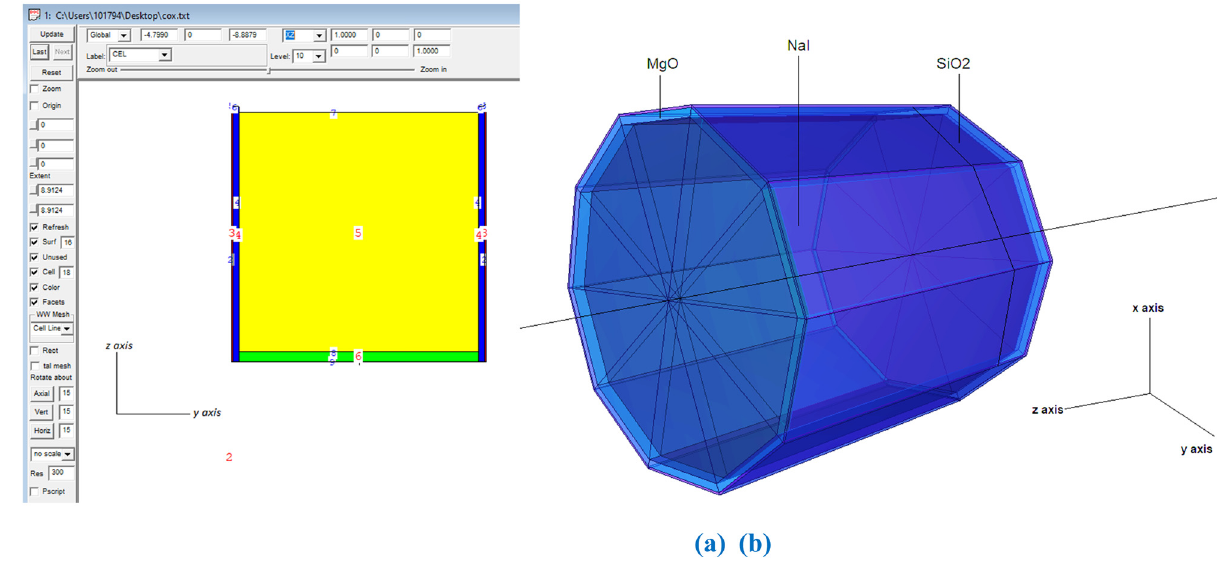
Figure 1: ( a ) Schematic 2 - D view and detailed coordinates of the modelled NaI ( Tl ) detector obtained from MCNPX Visual Editor ( VE VisedX22S ) and ( b ) 3 - D view and basic parts of the modelled NaI ( Tl ) detector obtained from MCNPX Visual Editor ( VE VisedX22S )